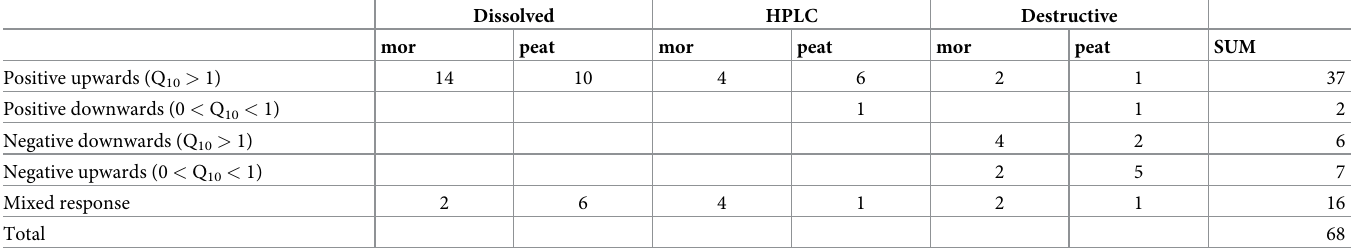
Table 6. Occurrence of different temperature response patterns in the multifactorial laboratory experiment. The response shapes and Q 10 values are presented in Figs 2–6.